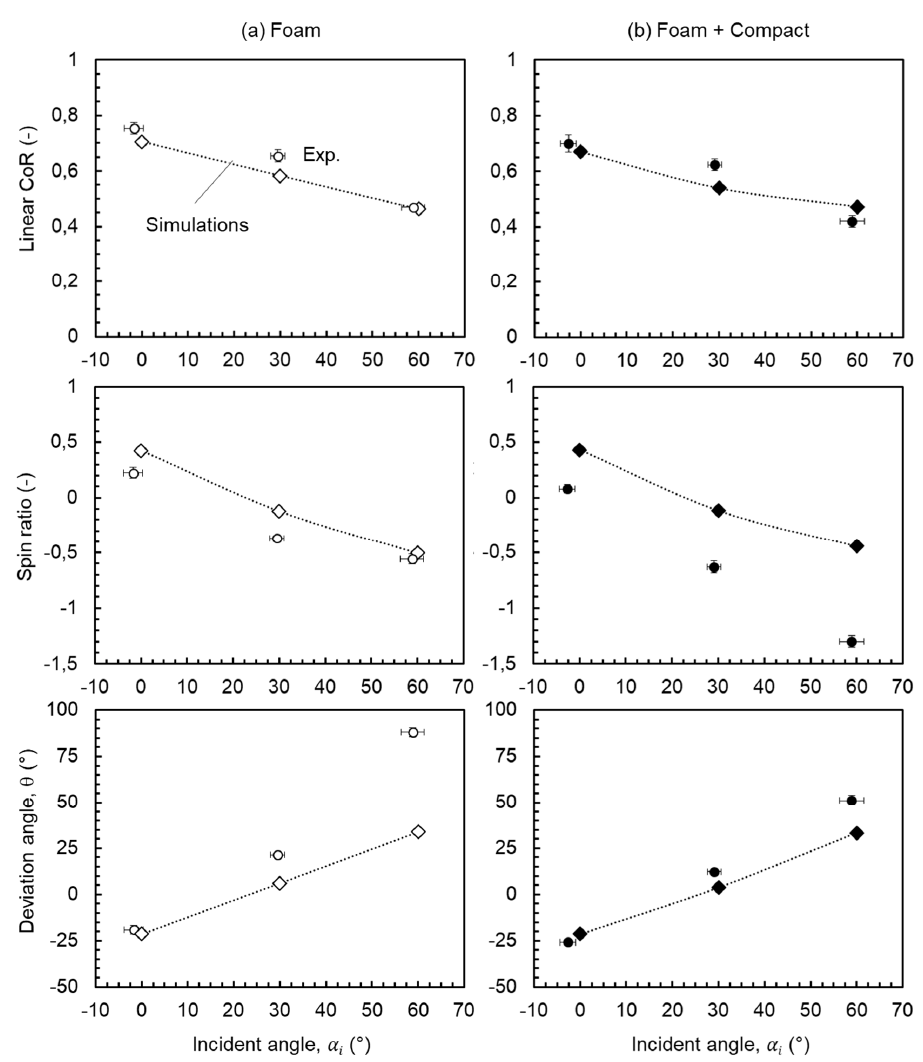
Figure 12. Model/experiments confrontations of the three metrics of performance as a function of the incident angle for impact (V i = 14 m/s and ω i = − 66 rev/s). ( a ) foam sample. ( b ) foam + compact sample.